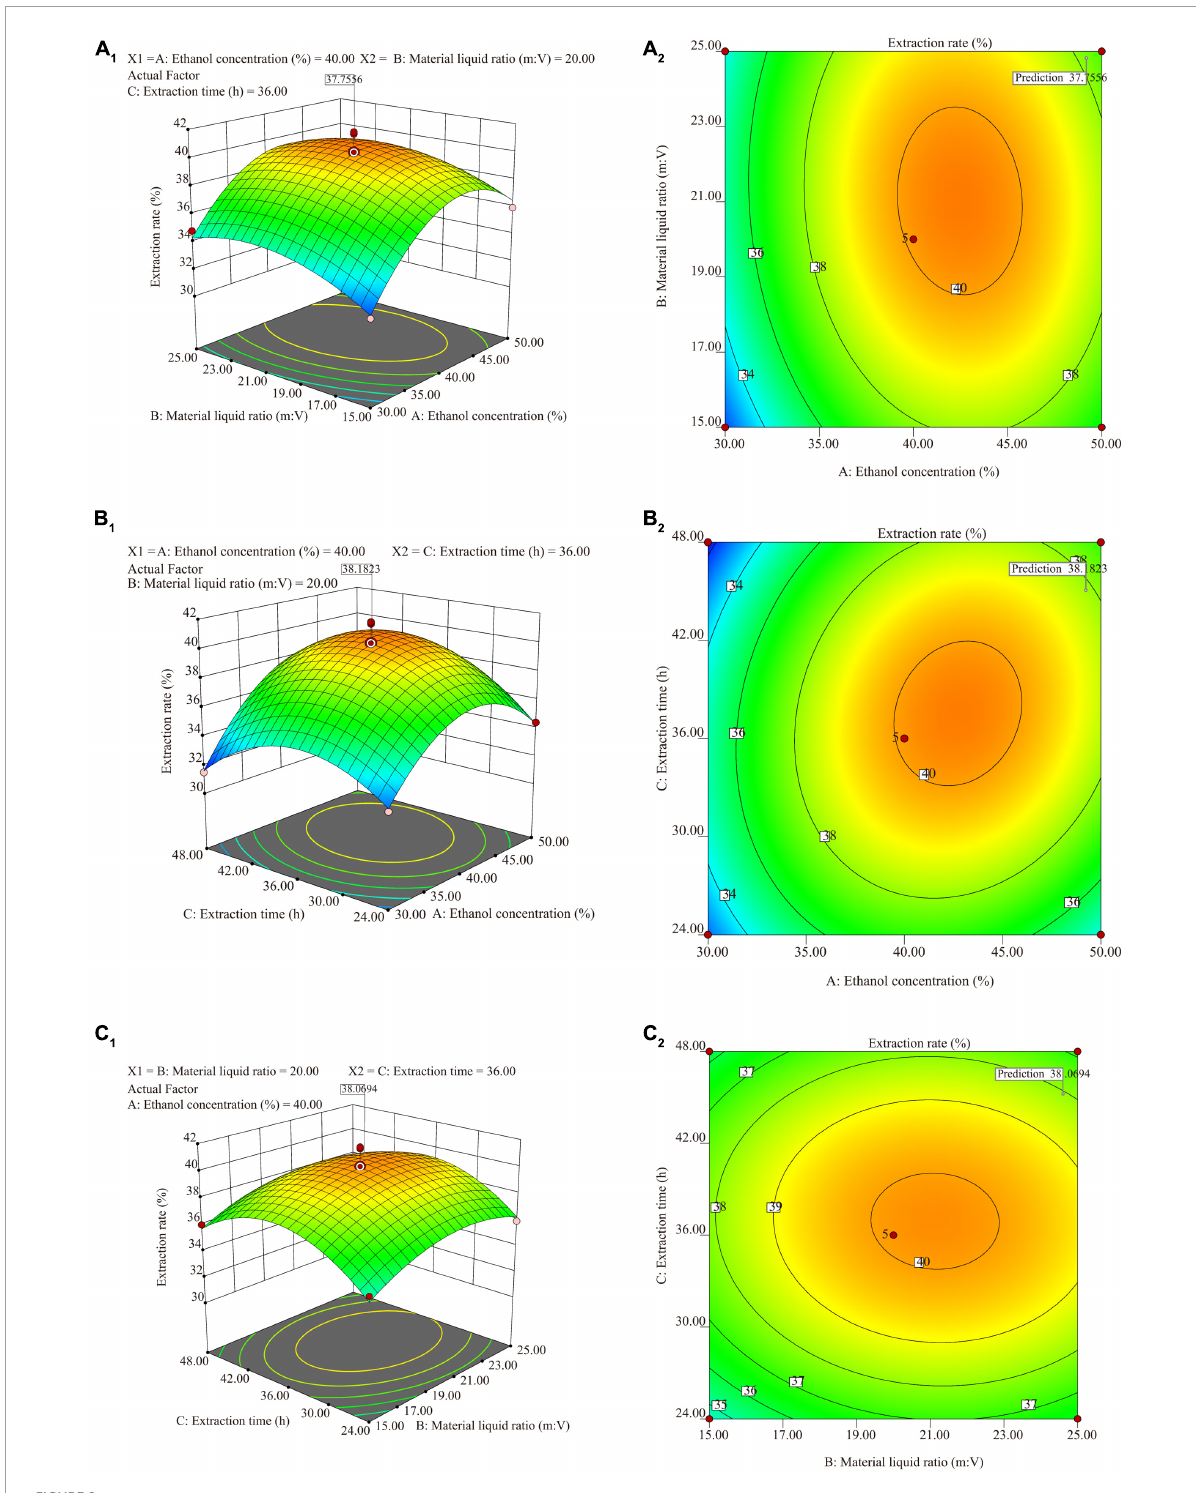
FIGURE2 The three-dimensional curved surface graph and contour plots for ethanol concentration vs. material liquid ratio (m:V) (A 1 ,A 2 ) ; ethanol concentration vs. extraction time (B 1 ,B 2 ) ; material liquid ratio vs. extraction time (C 1 ,C 2 )